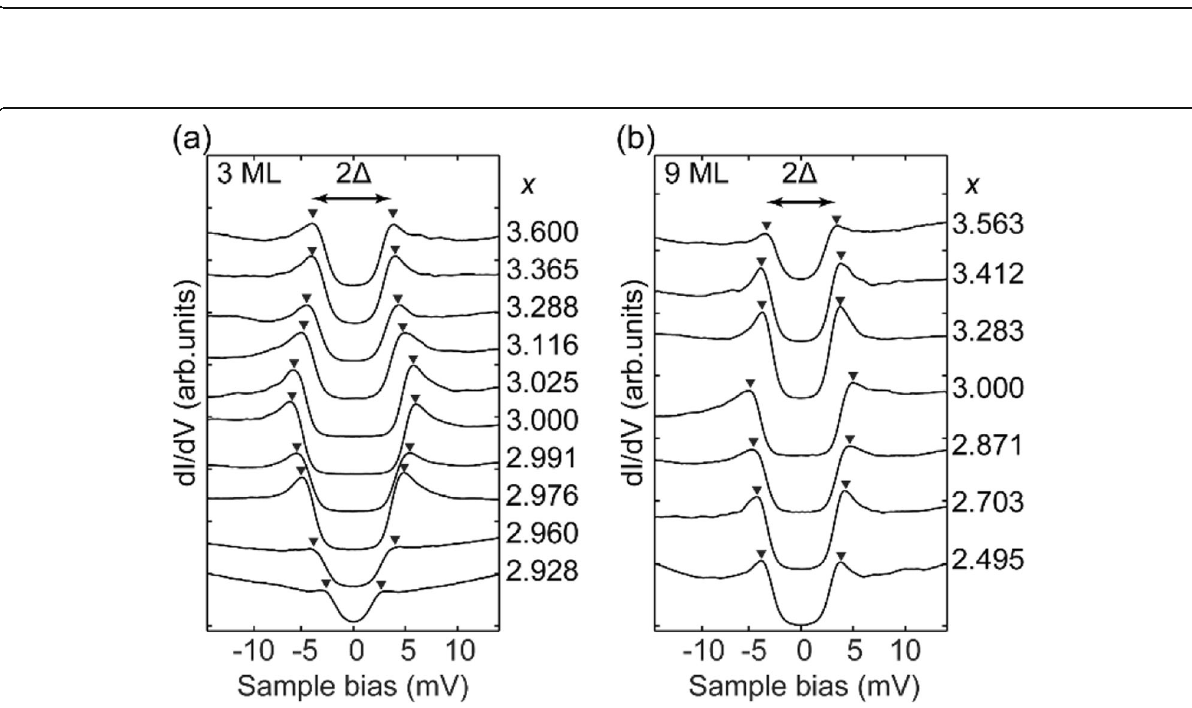
Fig. 17 Evolution of the averaged superconducting gap (measured at 4.5 K) with K doping x in 3 ML and 9 ML K x C 60 . The coherence peaks are marked by the black triangles for eye guide. Taken from ref.